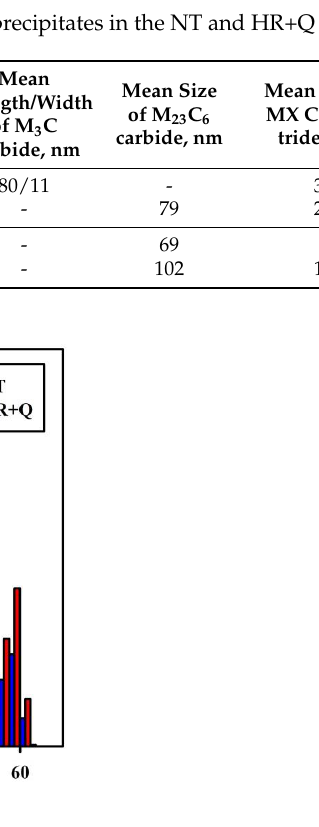
Table 2. Microstructural parameters and the mean size of precipitates in the NT and HR+Q samples.